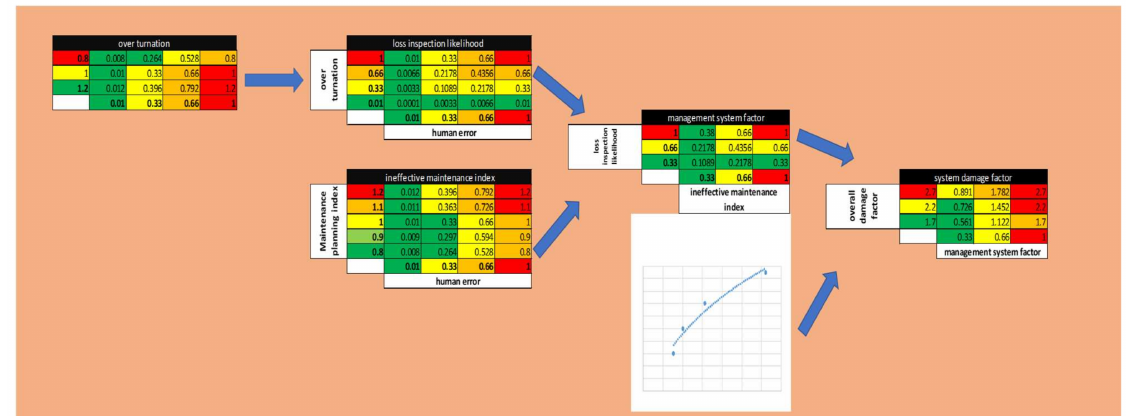
Figure 9. Values referred to management